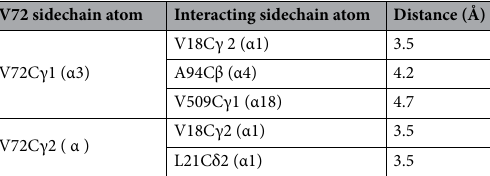
Table 3. Atomic distances between V72 of α3 and the surrounding residues of three